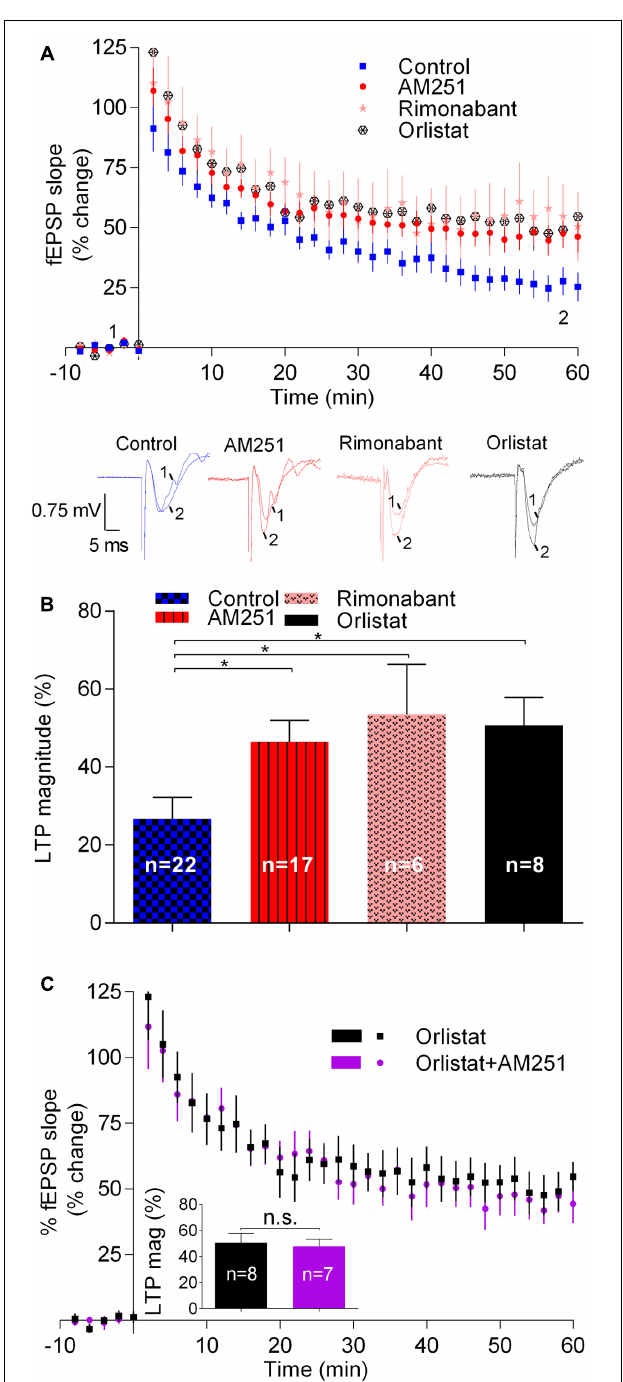
FIGURE 1 | Endocannabinoids inhibit LTP induced by weak- θ -burst stimulation (five trains of 100 Hz, 4 stimuli, separated by 200 ms). (A) Time course of the averaged fEPSP slopes in control conditions (no drugs) or in the presence of 1 µ M AM251 (CB 1 R inverse agonist), 1 µ M Rimonabant (CB 1 R antagonist), or 10 µ M Orlistat (a fatty acid synthesis inhibitor). Data are represented as % of the averaged fEPSP slope recorded for 10 min before LTP induction, which were taken as zero%. Original traces taken from representative individual experiments and recorded during the baseline (1)